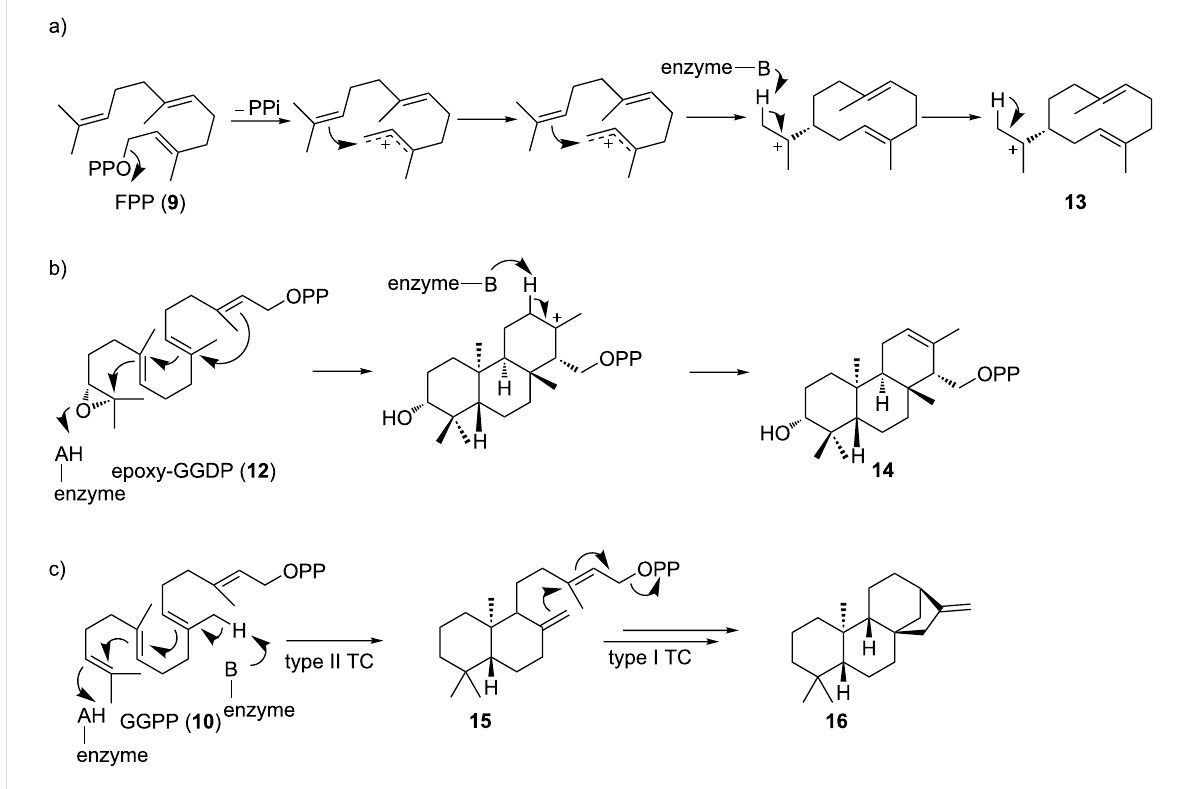
Figure 5: Mechanisms for type I, type II, and type II/type I tandem terpene cyclases. a) Tail-to-head class I germacrene A ( 13 ) cyclase. b) Head-to-tail type II brasilicardin ( 14 ) cyclase. c) Type II ent-copalyl diphosphate ( 15 ) synthase and type I ent-kaurene ( 16 ) cyclase.